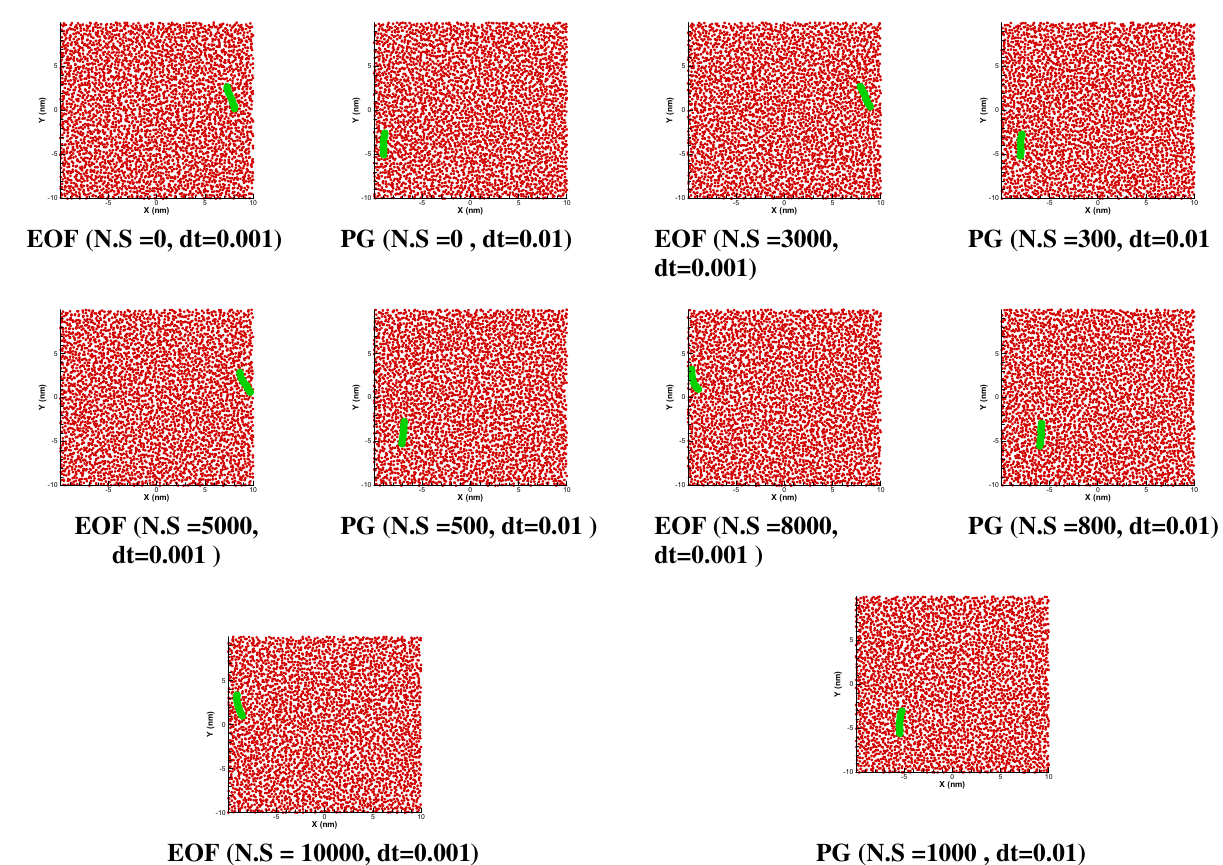
Figure 3. Free movement of the polymer chain in a simple channel under the influence of a constant external force (PG of 0.01 DPD unite) and electroosmotic force (EOF, Table 1) with spring coefficient of 8000 between the beads over number of steps (N.S) and time step for n =